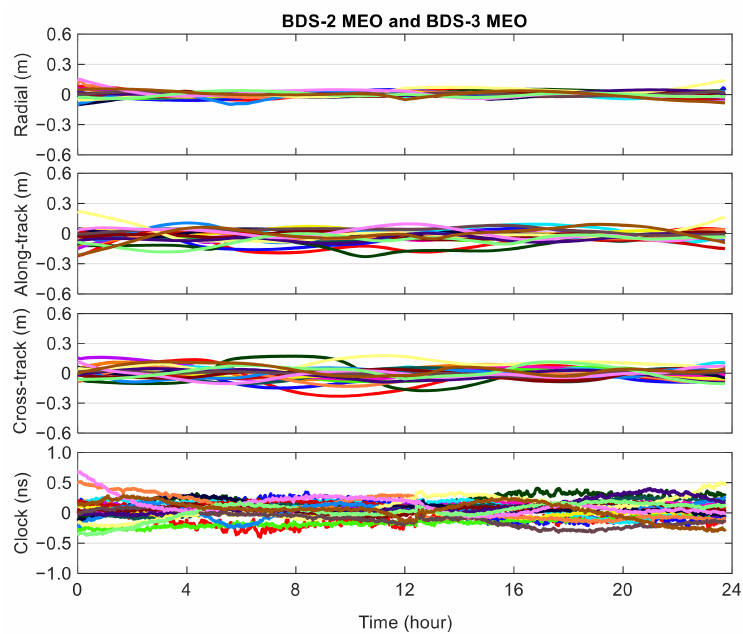
Figure 7. Epoch-wise orbit and clock differences for BDS-2 and BDS-3 MEO satellites between GFZ and WHU precise products on DOY 122 of